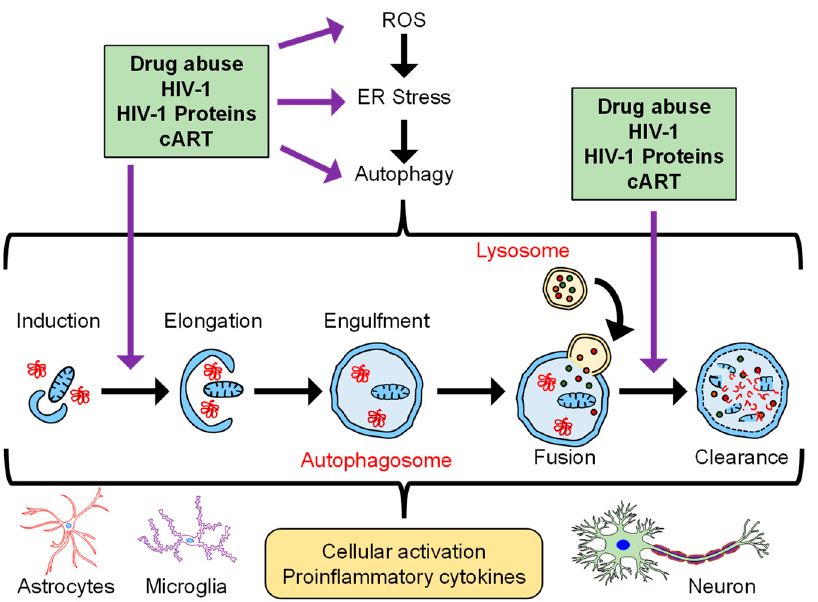
Figure 1. Schematic depicting the interplay of drugs of abuse, HIV-1/HIV-1 proteins, and cART in the context of autophagy and neuroinflammation.